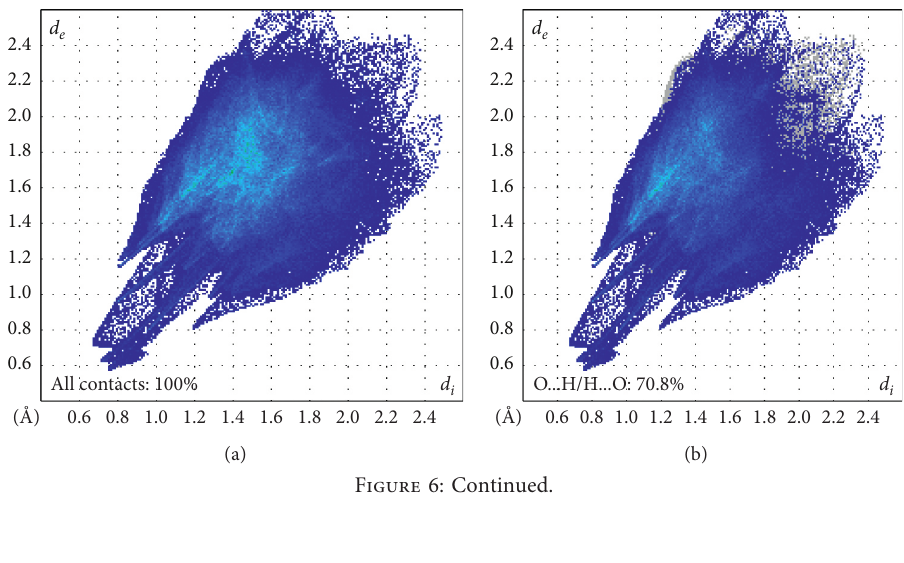
norm of the (C 7 N 3 H 20 ) 2 V 10 O 28